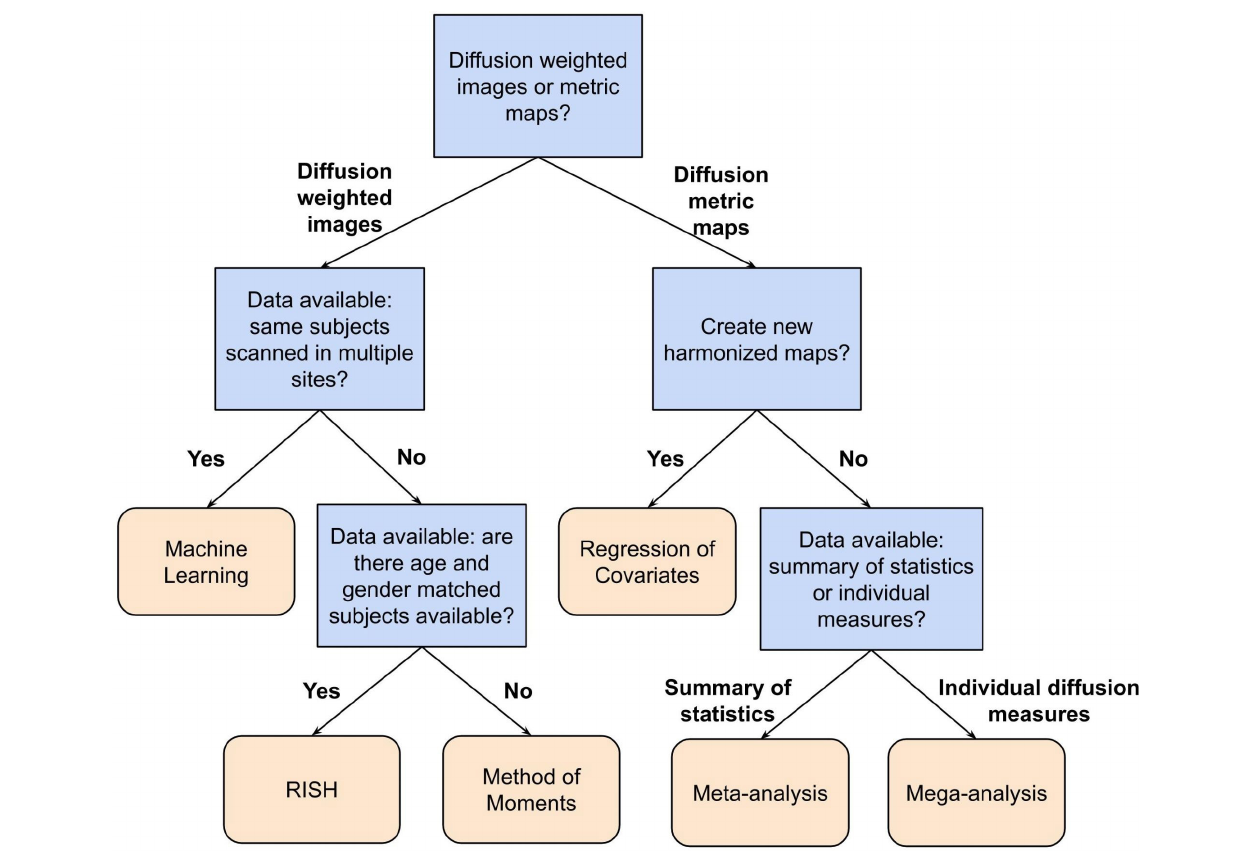
FIGURE 6 | Flowchart describing a possible way to select a suitable harmonization method depending on the available data and research question at hand. In this flowchart, the first question to be answered is: Do you want to harmonize the DWI or the diffusion metric maps? For harmonization of the diffusion metric maps (right segment of the flowchart), the following question is: Do you want to create new harmonized metric maps? If so, the suggested harmonization approach would be one of the regression of covariates methods. In case of a negative answer, the next question is: Do you have individual measures available or a summary of